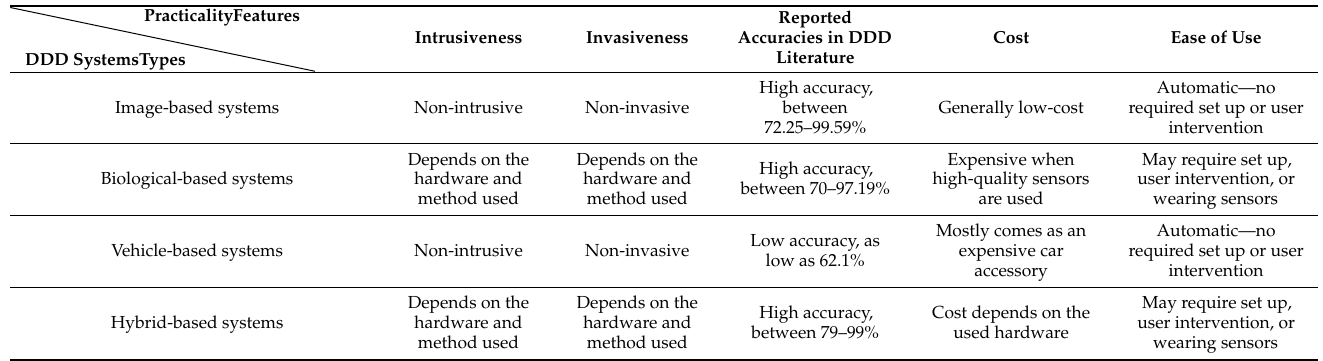
Table 10. DDD systems comparison, based on